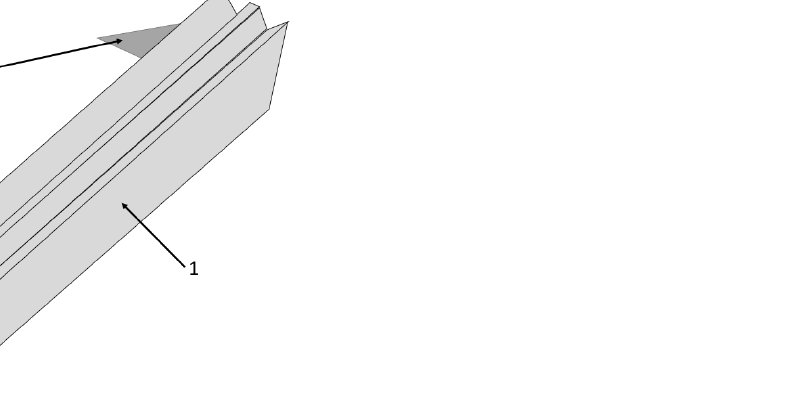
Figure 17. View of the RUPD structure based on a corrugated steel plate. 1—RUPD guard bar; 2—Support members